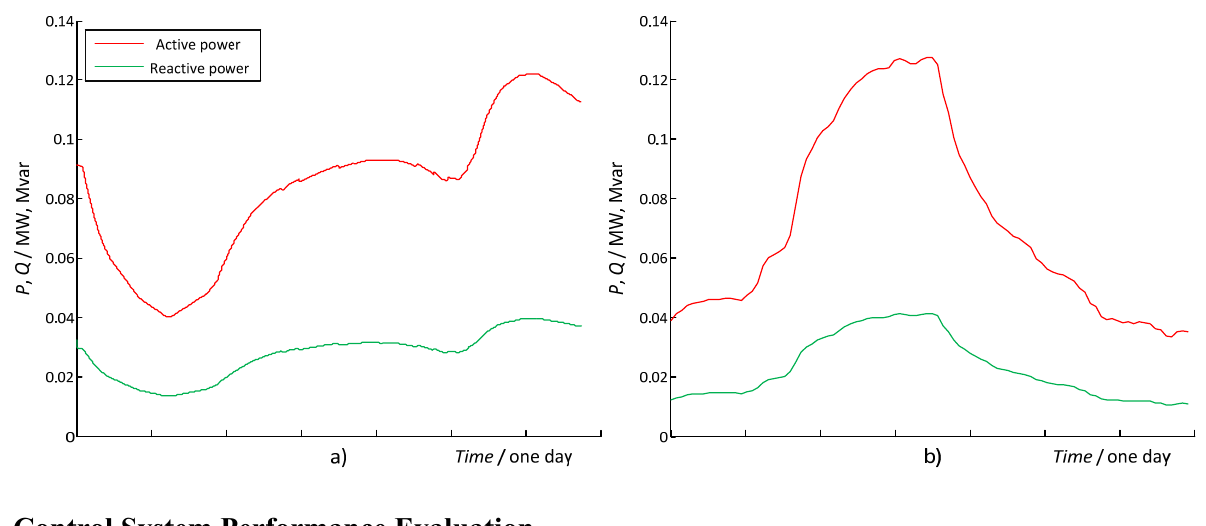
Figure 9. Typical LV substation daily load pattern for ( a ) residential and ( b ) industrial